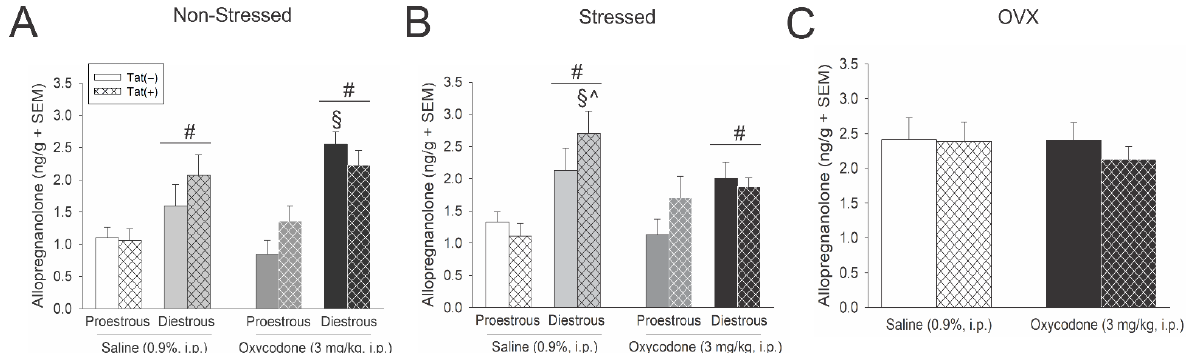
Figure 3. Proestrous, diestrous or ovariectomized (OVX) Tat(−) and Tat(+) mice described in Figure 1 had allopregnanolone content (ng/g) assessed in the hypothalamus in ( A ) non-stressed, ( B ) stressed, and ( C ) OVX mice ( n = 8/group). # indicates a main effect for diestrous mice to differ from proestrous mice. § indicates an interaction wherein the denoted group differs from Tat(−) or Tat(+) proestrous mice. ^ indicates an interaction wherein the denoted group differs from oxycodone-administered, Tat(+) diestrous mice, p < 0.05. In summary, hypothalamic allopregnanolone was greater among diestrous, com- pared to proestrous, mice and OVX apparently increased basal allopregnanolone content and obviated oxycodone- or Tat-mediated fluctuations.